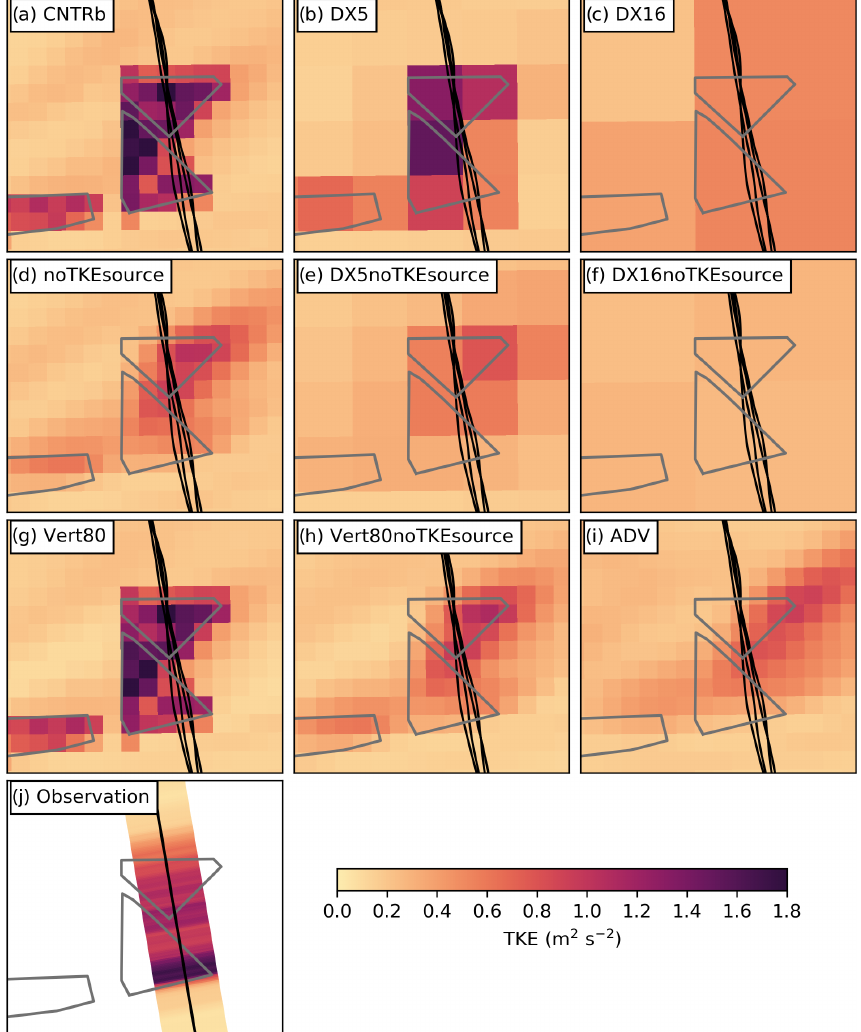
Figure 12. As in Fig. 9 but for the sensitivity simulations (b–i) DX5, DX16, noTKEsource, DX5noTKEsource, DX16noTKEsource, Vert80, Vert80noTKEsource and ADV at 15:00UTC. A summary of all sensitivity tests is listed in Table 2. For better comparison, the control simulation CNTRb is shown in panel (a) and the observations in (j)